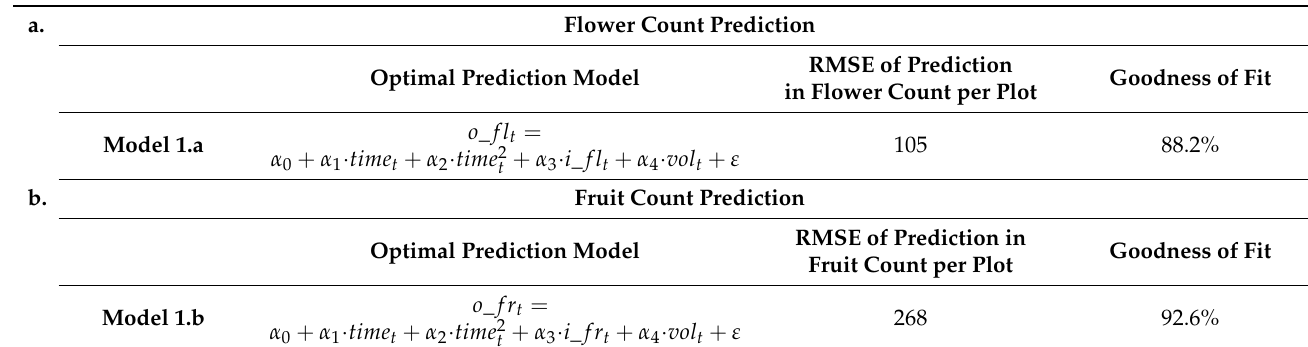
Table 3. Count Prediction Models and their